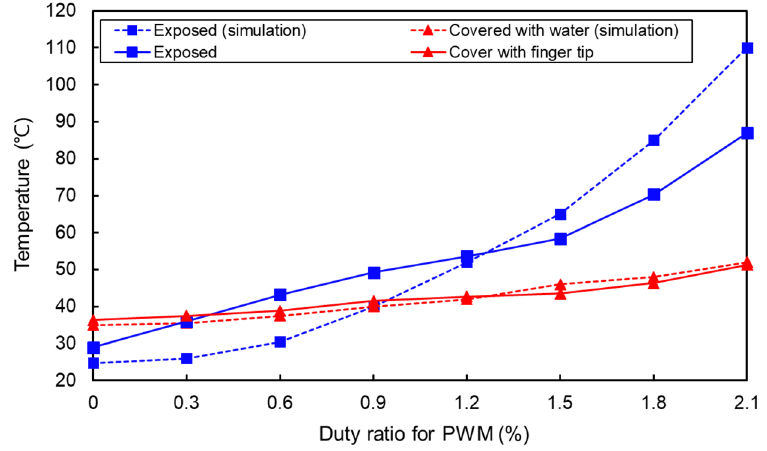
Figure 11. Heater temperature according to the duty ratio of the PWM control signal.